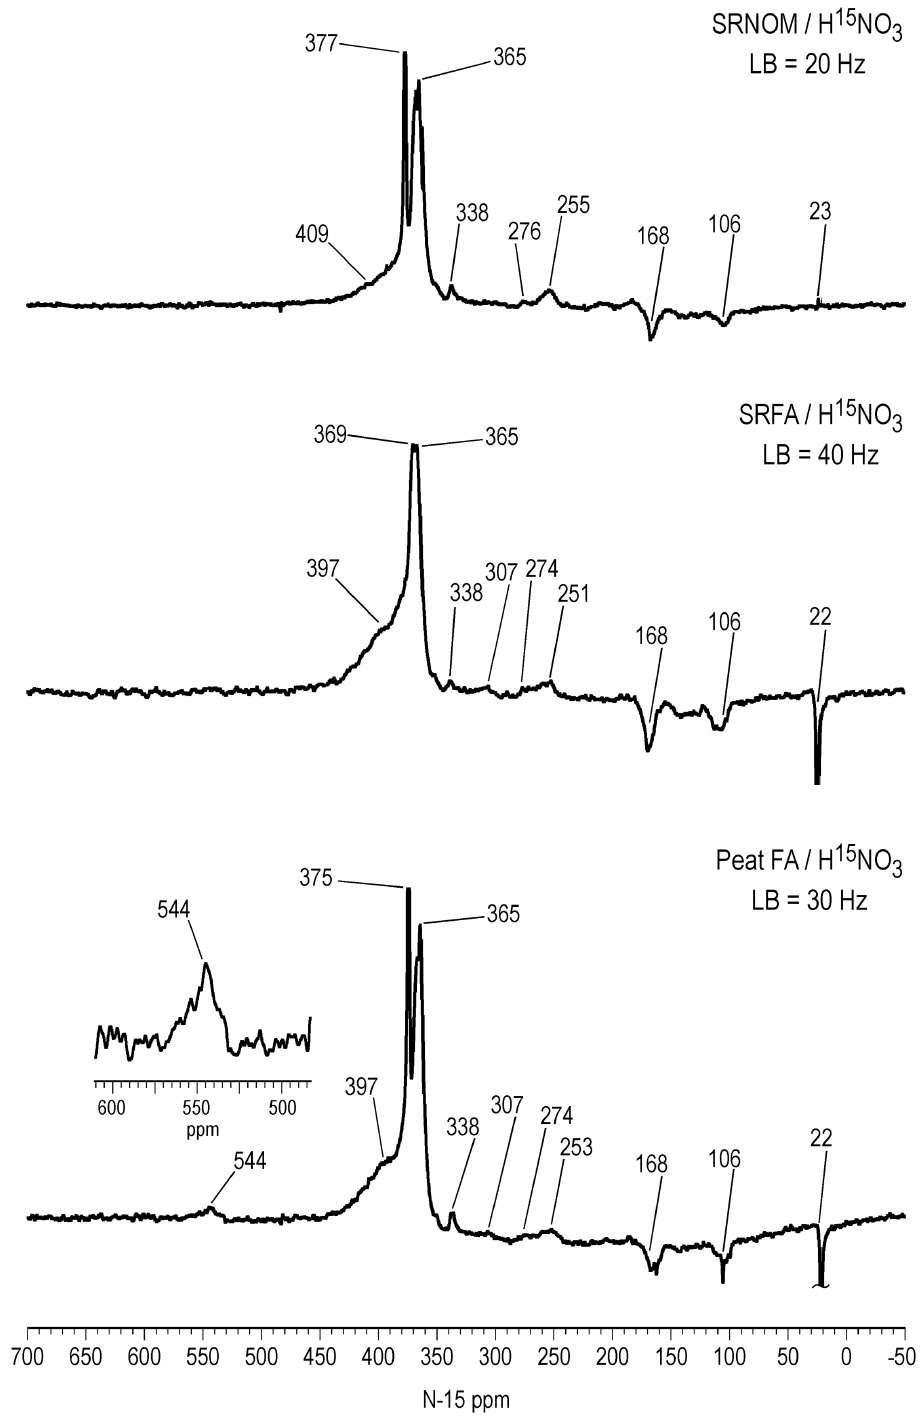
Fig 1. Liquid state ACOUSTIC N-15 NMR spectra of Suwannee River NOM, Suwannee River FA and Pahokee Peat FA treated with N-15 labeled nitric acid. LB = line broadening.